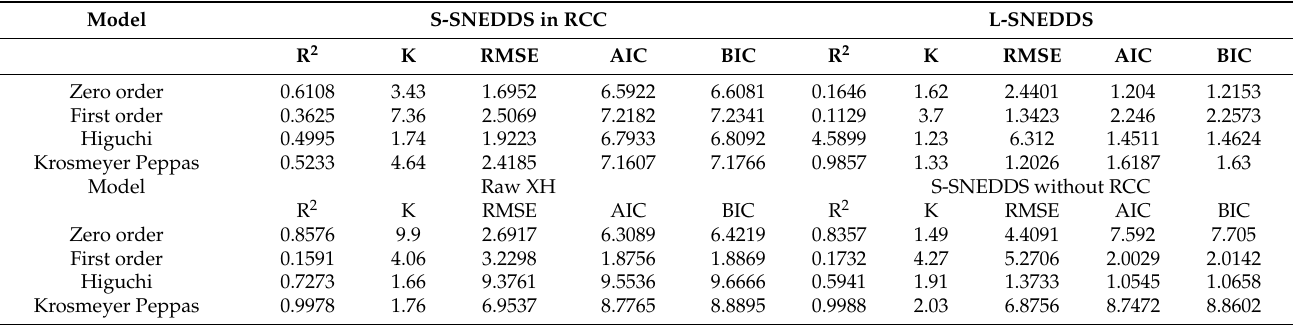
Table 4. Results of release kinetic profiles of Raw XH, L-SNEDDS, S-SNEDDS without RCC and S-SNEDDS in RCC.